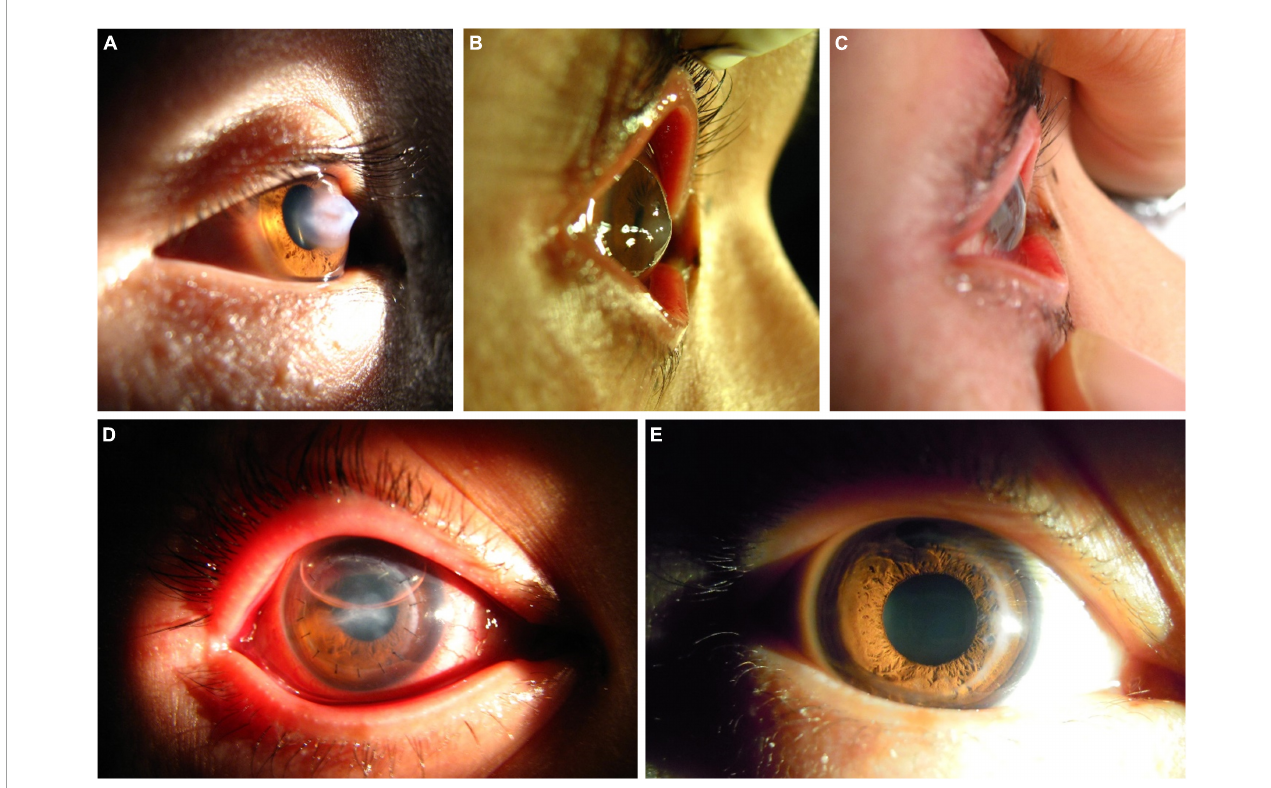
FIGURE3 A patient with ACH treated with the epikeratophakia–DALK combination after a first treatment with thermokeratoplasty. (A) Acute onset ACH, with severe edema of the corneal stroma. (B) At 2 weeks after thermokeratoplasty a recurrence of edema was evident centrally, and epikeratophakia was performed immediately. (C,D) At 2 days after epikeratophakia, the corneal haze and edema had noticeably subsided. (E) At 3 months after DALK using the same graft, the cornea was transparent.